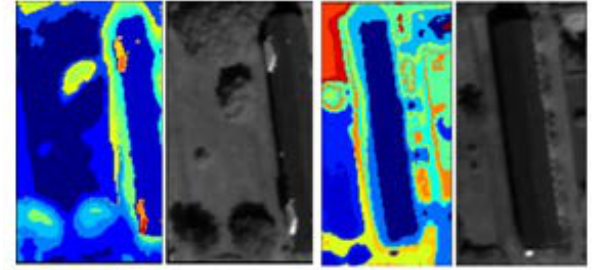
Figure 6. Overlaying detected shadows from multispectral image on the DSM